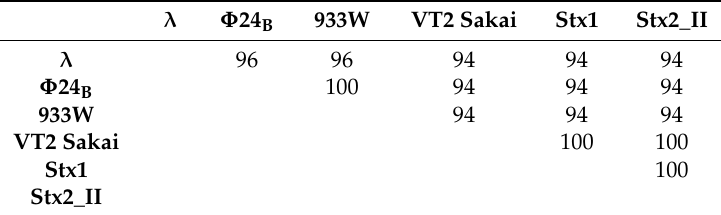
Table 2. Scores of pairwise alignments of the nucleotide sequences of orf60a from six analyzed lambdoid